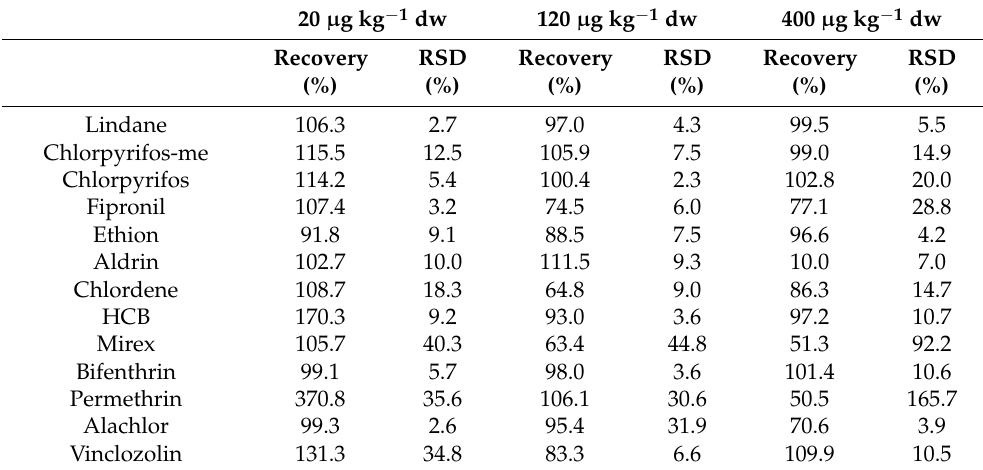
Table 5. Interval (minimum–maximum) of mean extractive recoveries (%) and RSD for the analytes at three concentrations for the bivalve